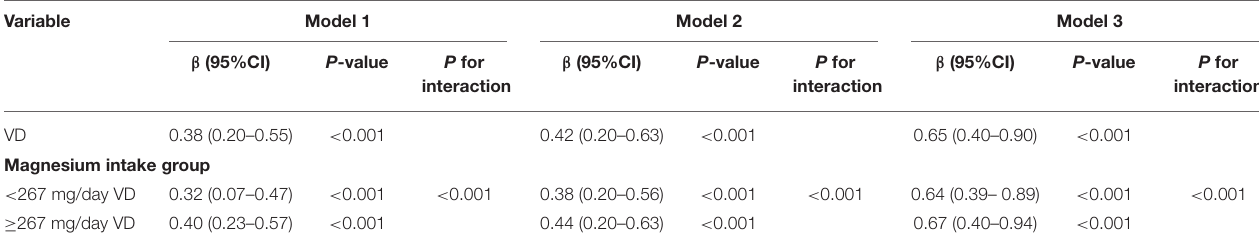
TABLE 3 | Interactive effect of vitamin D and dietary magnesium intake on HOMA- β